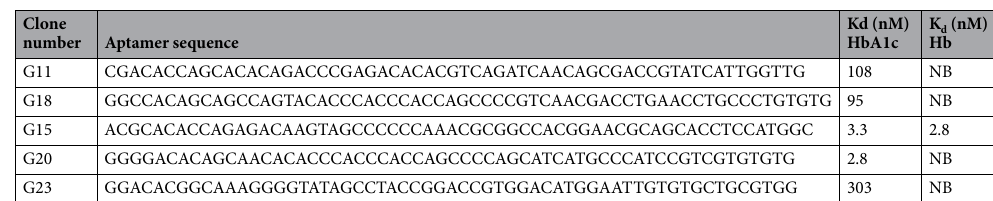
Table 1. Sequences and dissociation constants ( K d ) between Hb and HbA1c and selected aptamers.